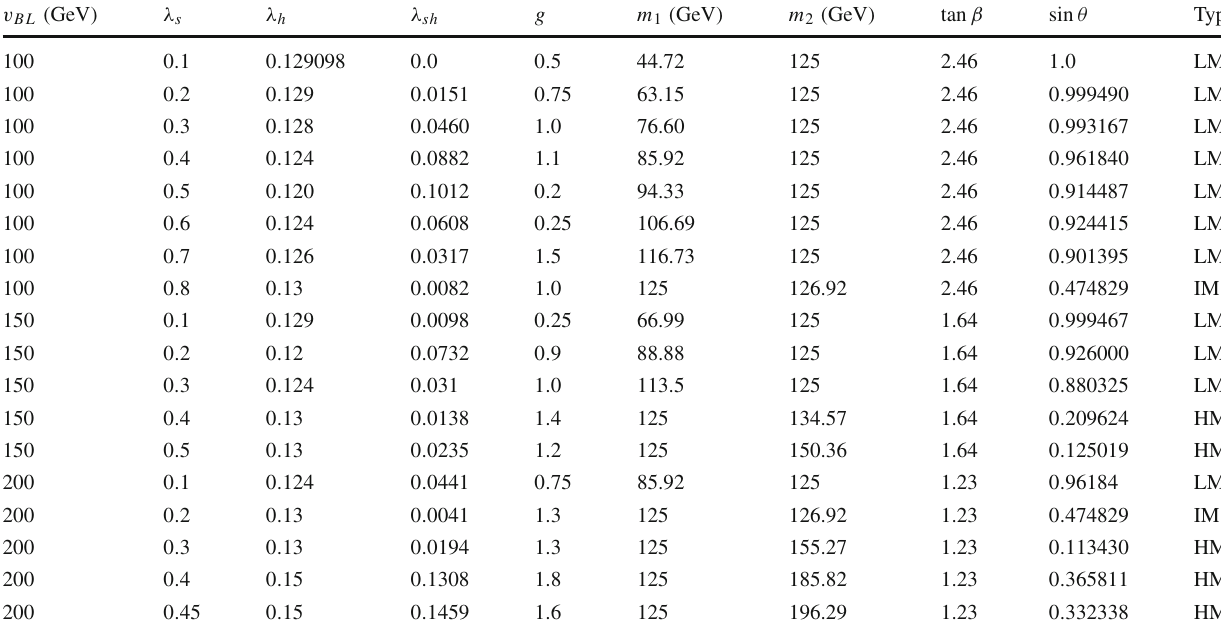
Table 2 More parameters in Fig. 4. LM: low mass region; IM: intermediate mass region; HM: high mass region